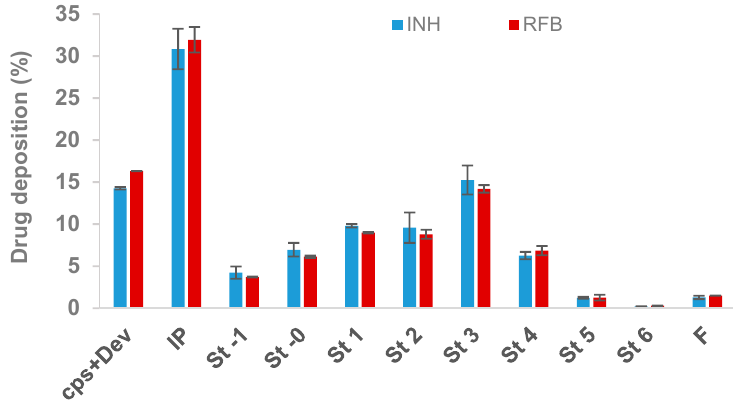
Figure 3. In vitro aerodynamic deposition of antitubercular drugs (INH and RFB) in the Andersen cascade impactor. Drugs were associated with spray-dried fucoidan microparticles. Values are mean ± SD, n = 3. Cps: capsule; Dev: inhaler device; IP: induction port; F: filter, INH: isoniazid; RFB: rifabutin St: stage.